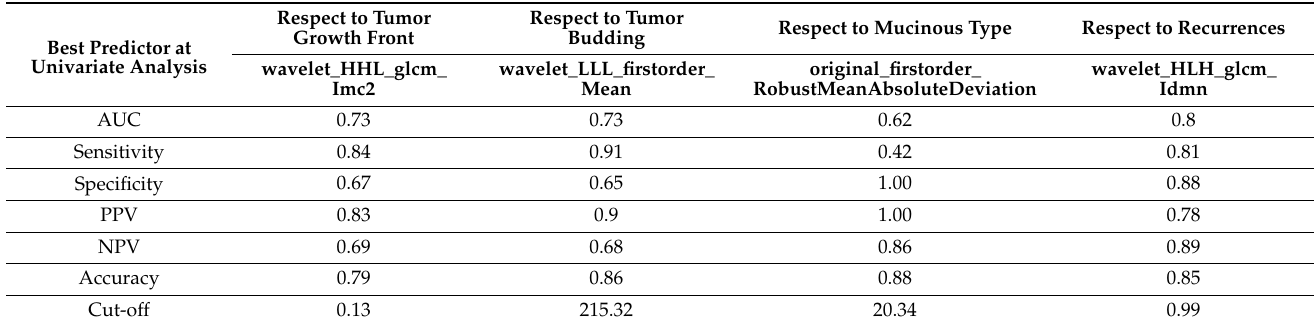
Table 3. Findings by univariate analysis with ROC performance